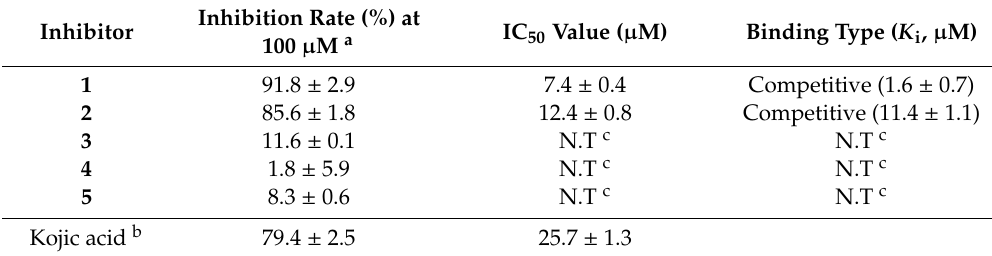
Figure 2. The inhibitory activities of compounds 1 – 5 at 100 μ M concentration toward tyrosinase ( A ). IC 50 values ( B ), Lineweaver-Burk plots ( C , D ), Dixon plots ( E , F ) of two inhibitors 1 and 2 , respectively. Table 1. Inhibitory activity of isolated compounds 1 – 5 from L. japonicas toward tyrosinase.